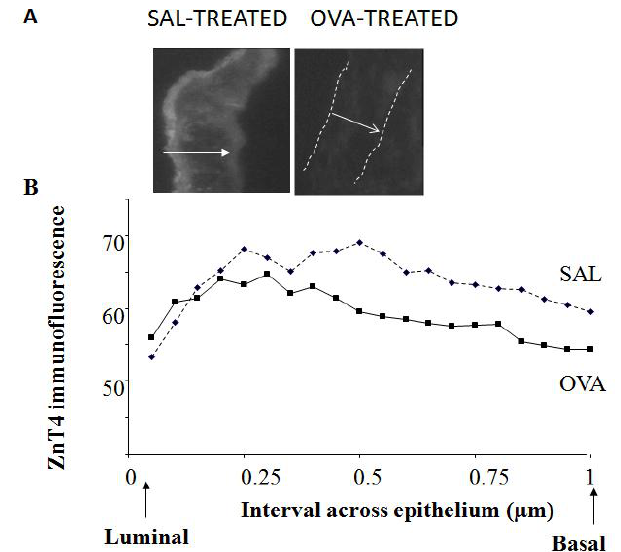
sham-treated control Balb/C mouse (left) and OVA-treated Balb/C mouse (right). In the latter photomicrograph, the dashed lines indicate the orientation of the epithelium. The arrow indicates the width of the epithelium from luminal (tail of arrow) to basal (head of arrow). Note the stronger ZnT4 fluorescence at the luminal (apical) end in the control section and the loss of fluorescence in the OVA-treated mouse AE; ( B ) Figure shows the loss of ZnT4 fluorescence averaged over a number of mice. Mean fluorescence intensity per interval across the epithelium is shown, from luminal end (left) to basal end (right). Means were from multiple images (5–10 per mouse) for a total of 10 SAL and 11 OVA mice. There was a significant loss of ZnT4 staining in the OVA-treated mice ( P < 0.005), preferentially in the basal